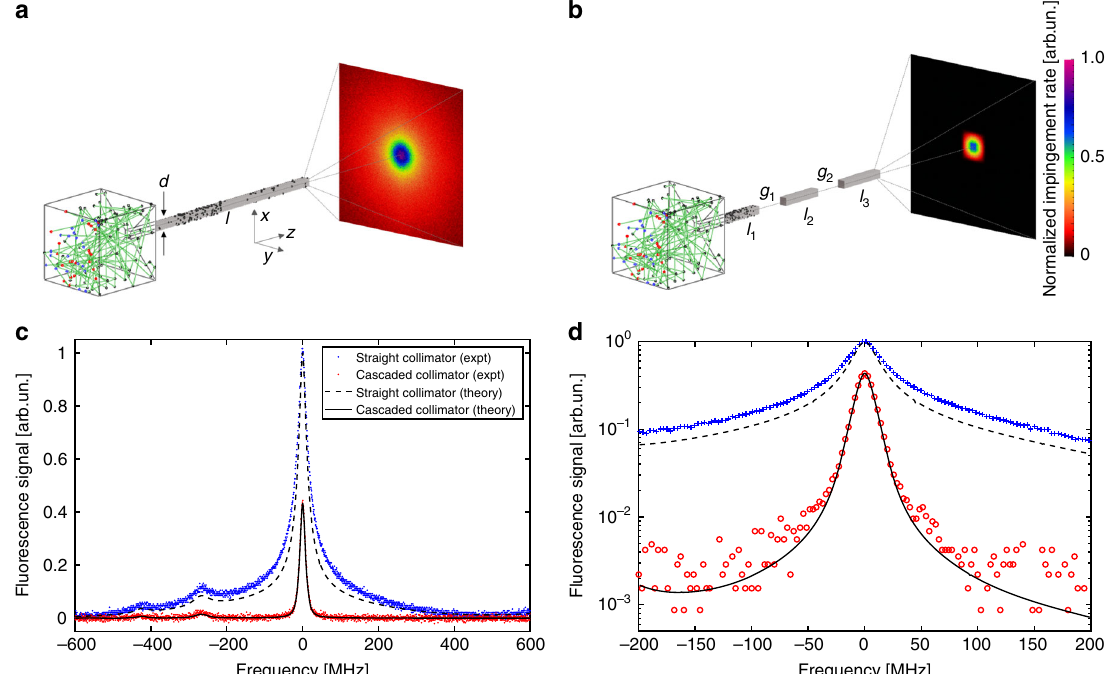
Fig. 2 Cascaded collimator concept for high purity atom beam generation. a Directed atomic beams generated by a collimating tube, one end of which is connected to a high density atomic vapor comprising an effusive emission source. Two-dimensional image shows the output fl ux angular distribution